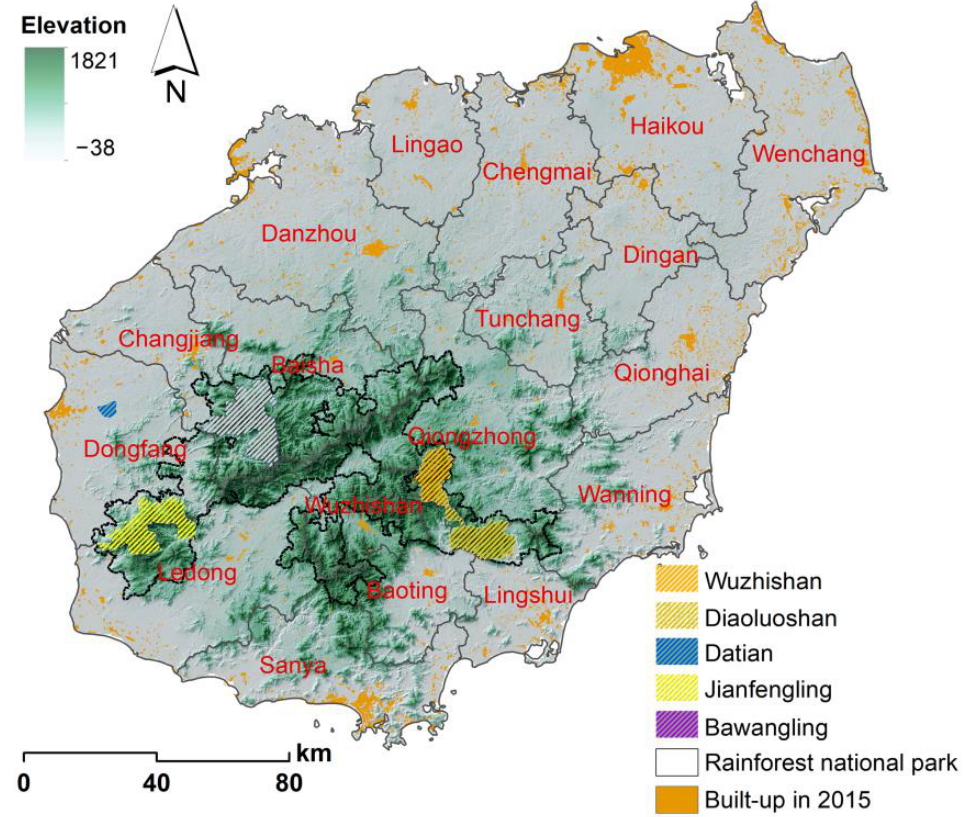
Figure 1. Map of Hainan Island.